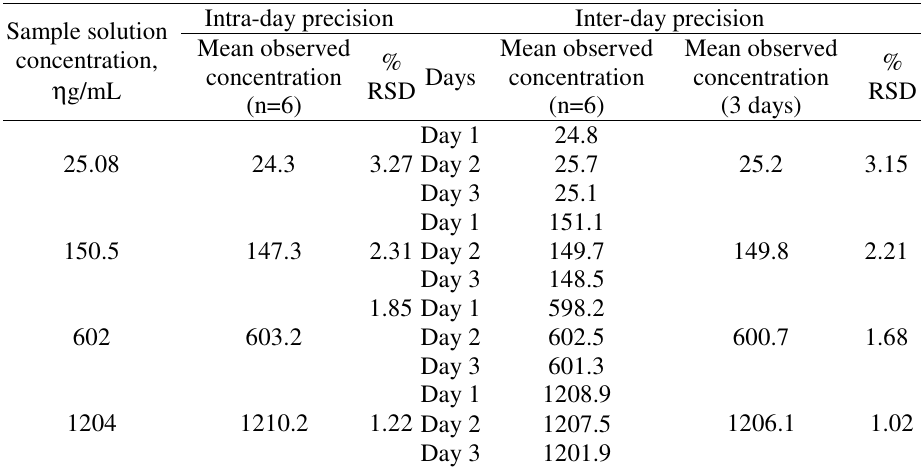
Table 3. Inter-day and intra-day precision studies for the determination of voglibose in sample D (containing 0.301 mg voglibose) using LC-MS/MS